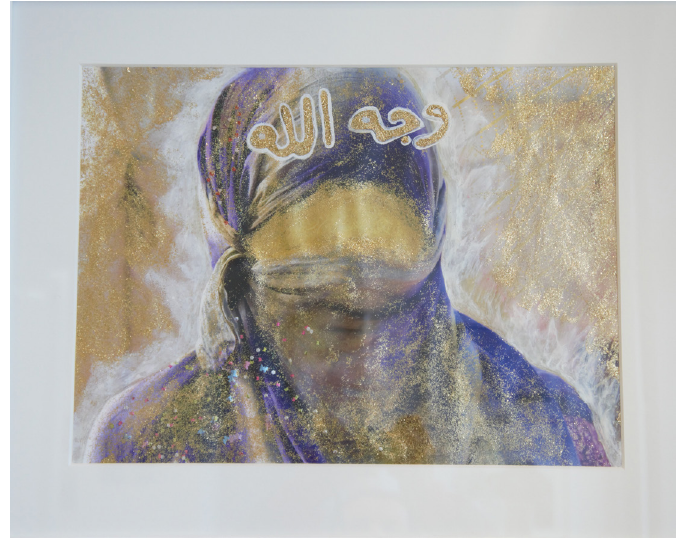
Figure 4: Face of